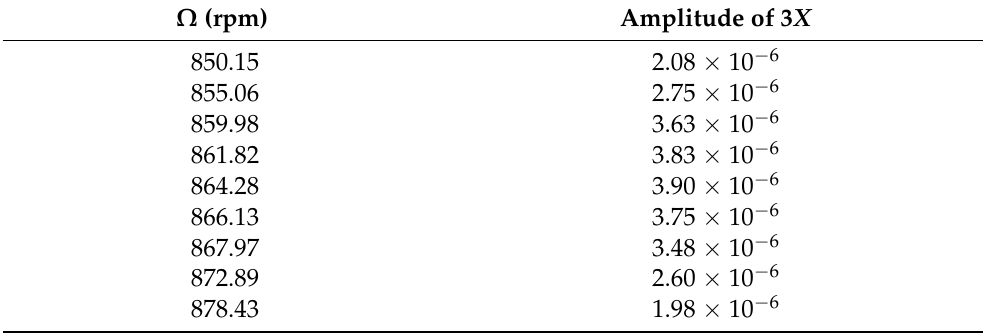
for α = 0.01 in 3